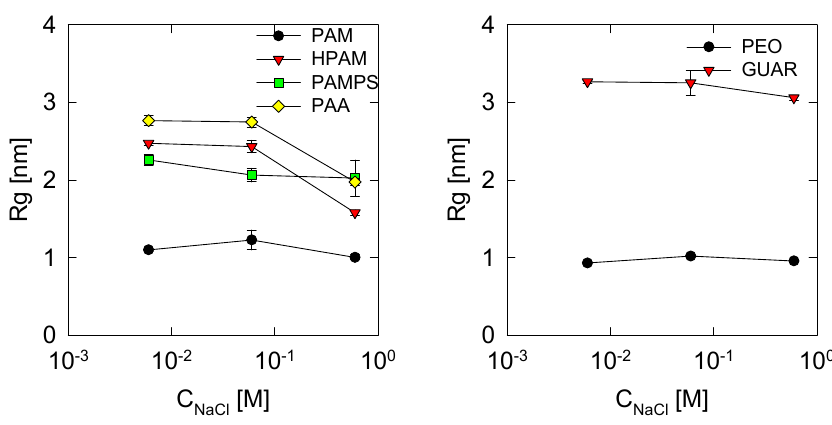
Figure 2. Radius of gyration of the polymers studied at different concentrations of NaCl.